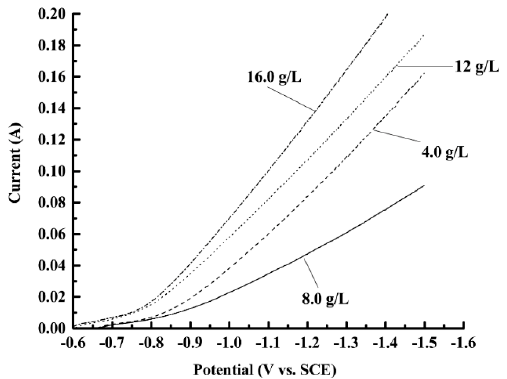
Figure 3. Cathodic polarization curves tested in solutions containing different concentrations of nanodiamond powder.